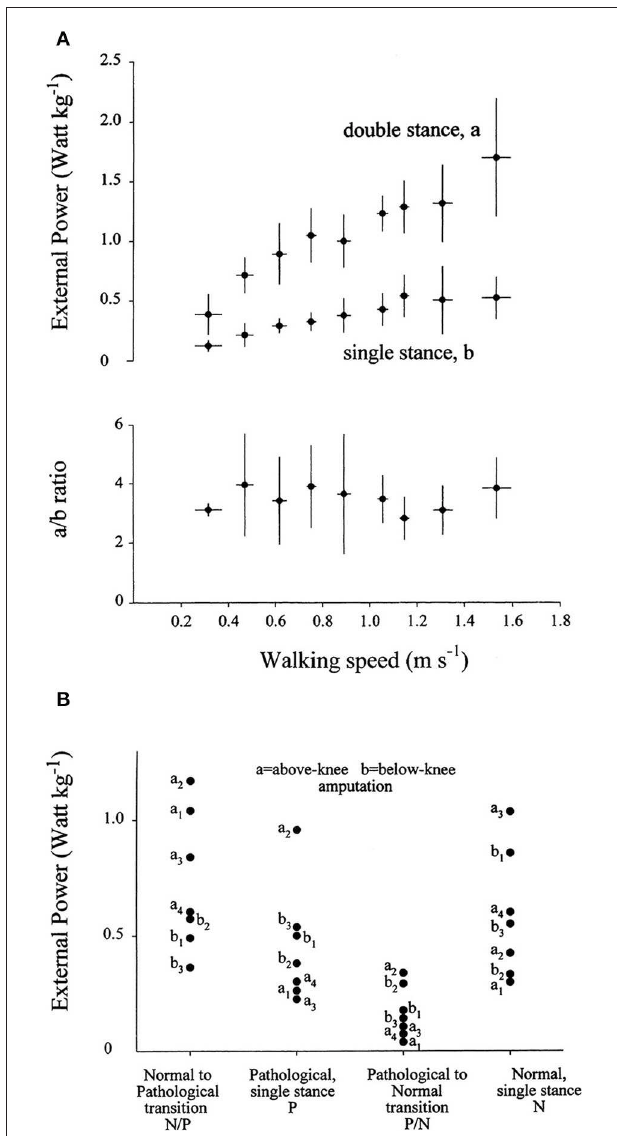
FIGURE 8 | (A) The upper panel gives the average of the weight-normalized external power provided by muscles to sustain the increments of the total mechanical energy of the center of mass (CoM) (E tot , see Figure 5 ) during walking at different speeds (on the abscissa). Power was measured during the increments of E tot that occur during the double- and single-stance phases of the step (a and b, see Figure 5 ). Lower panel: the a/b ratio plotted as a function of speed. Power is invariably higher during the double-compared with the single-stance phase of the step. Taken from Tesio et al. (20), used with permission. (B) The ordinate gives the average power provided by muscles to sustain the a and the b increments (during double and single stance, respectively) of the total mechanical energy of the CoM (E tot , see also Note S5 ) during one entire stride in three below-knee (dots labeled b1–b3) and four above-knee (dots labeled a1–a4) amputees. The N and P labels indicate the single-stance phases of the stride on the normal and prosthetized lower limbs, respectively. The N/P and P/N labels indicate the double-stance phases of the stride (normal limb behind or prosthetic limb behind, respectively). During the N to P transition, much more power is generated when the unaffected limb is trailing, compared to when it is leading. Taken from Tesio et al. (66), used with permission.